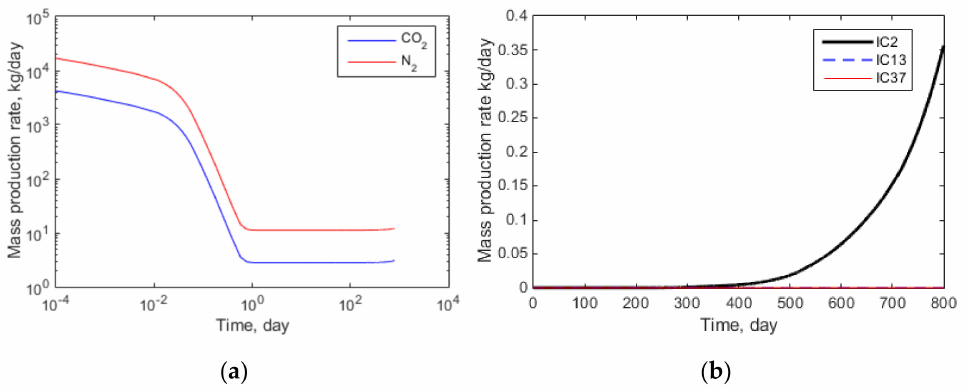
Figure 14. Production curves of inorganic and organic components of production wells calculated. ( a ) Inorganic component; ( b ) organic